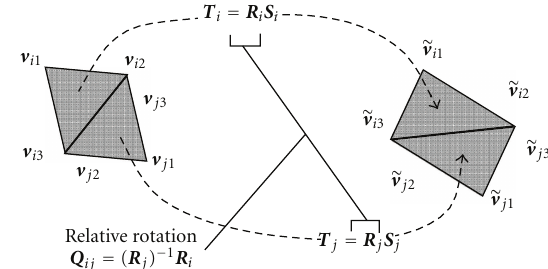
Figure 2: Rotation-invariant encoding. We first compute the defor- mation gradients. We then decompose these into absolute rotations and scale/shear components. While the scale/shear components are rotation invariant, the absolute rotations are not. Thus, we compute a relative rotation of two adjacent triangles to remove a global